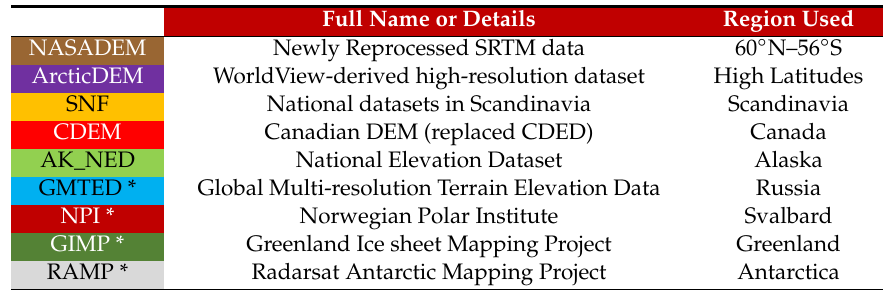
Table 1. Datasets that comprise new Landsat (Collection-2) Digital Elevation Model (DEM). The color of the headings shows where they are geographically in Figure 1.